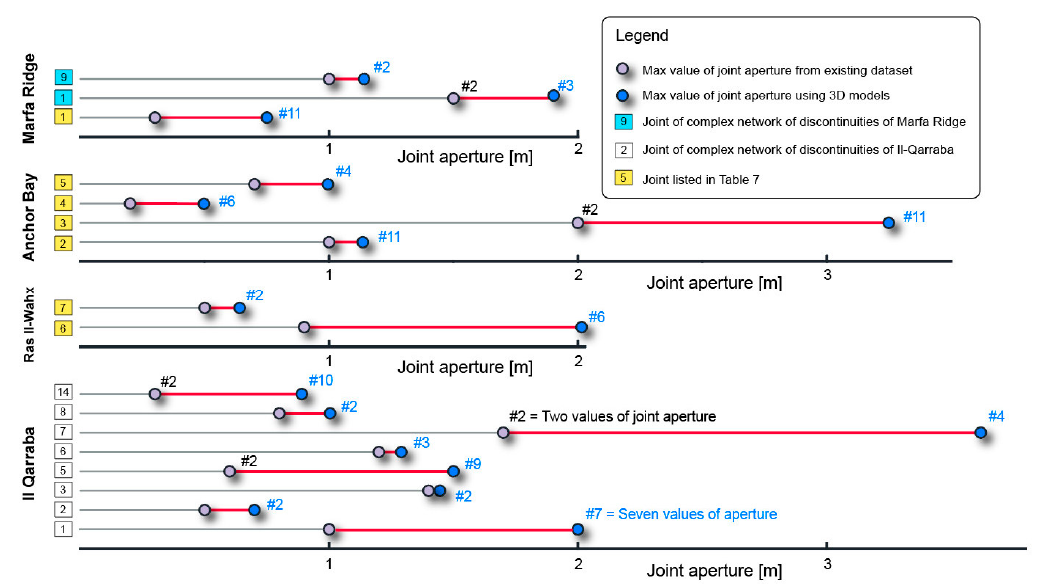
Figure 15. Joint apertures determined using field measurements from existing dataset and DP-derived 3D models in the four localities.